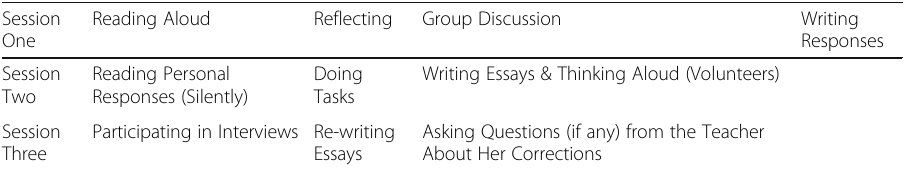
Table 3 Classroom procedure in each cycle Session Reading Aloud Reflecting One Session Two Session